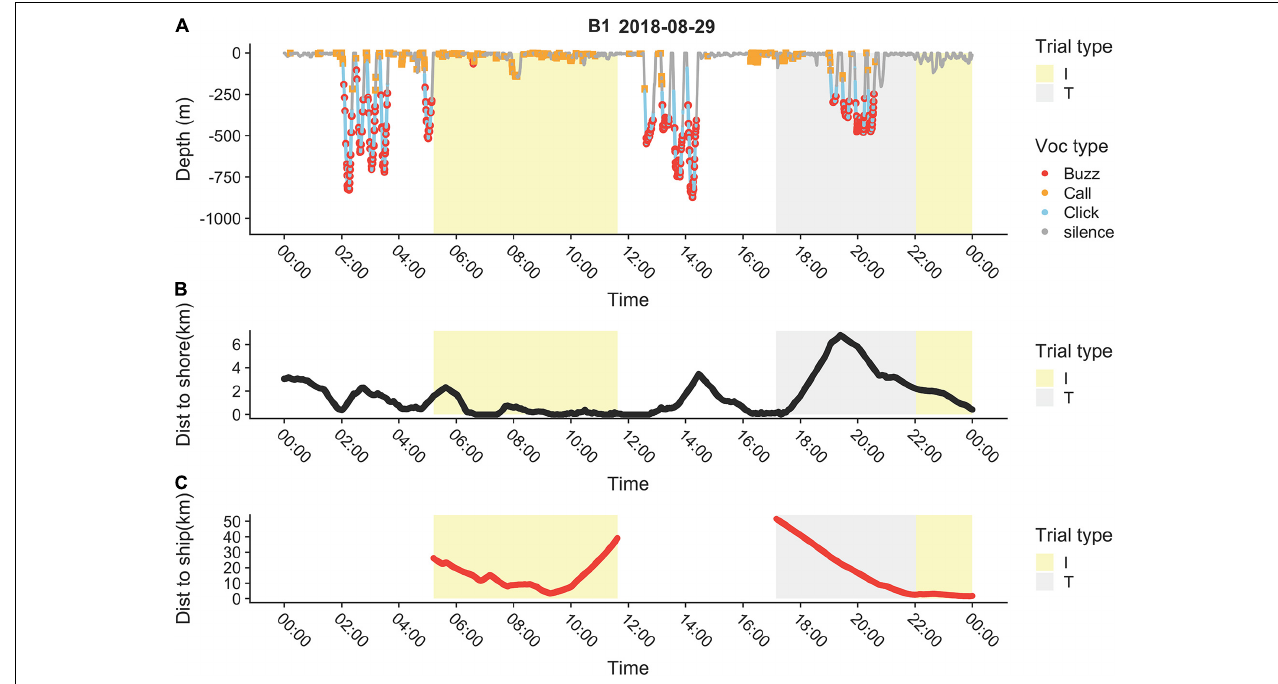
FIGURE 9 | Example of storyboard with (A) diving and vocalization, (B) distance to coast, and (C) distance to ship during 1 day for one whale (B1) that was tagged in 2018. Trials (T) are shown in gray and intertrials (I) in yellow.